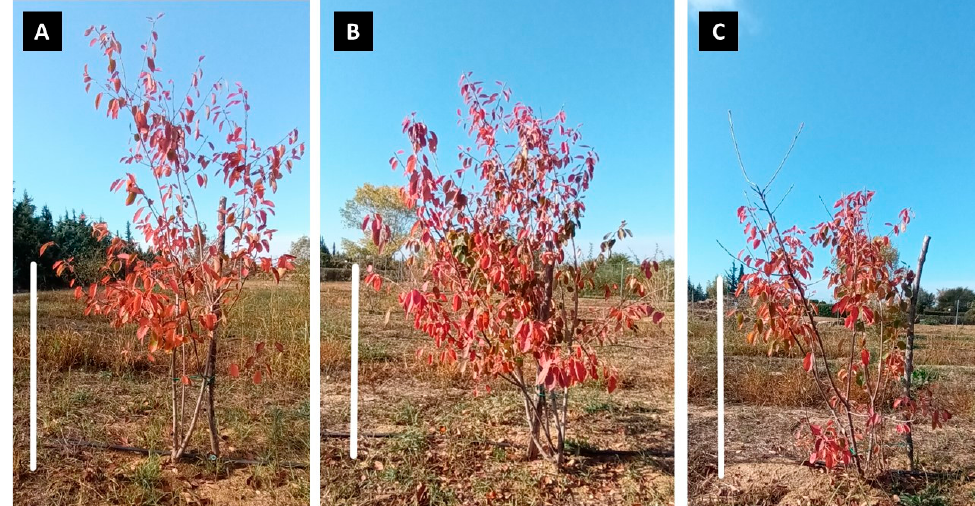
Figure 4. Representative growth of Amelanchier ovalis subsp. ovalis GR-1-BBGK-04,2547 trees in the pilot field (Thermi, Thessaloniki, Greece) during autumn 2022 with discolored leaves before shedding after different fertilization regimes applied (( A ) control; ( B ) conventional fertilization; ( C ) organic fertilization). The bars in the photos represent 1 m.